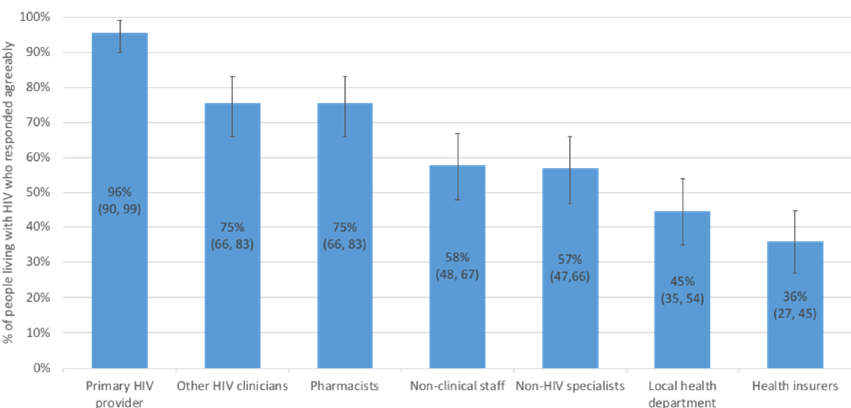
Figure 2. Preferences of people living with HIV for sharing their personal health information with others. Percentages are displayed with 95% confidence intervals in others. Percentages are displayed with 95% confidence intervals in brackets.